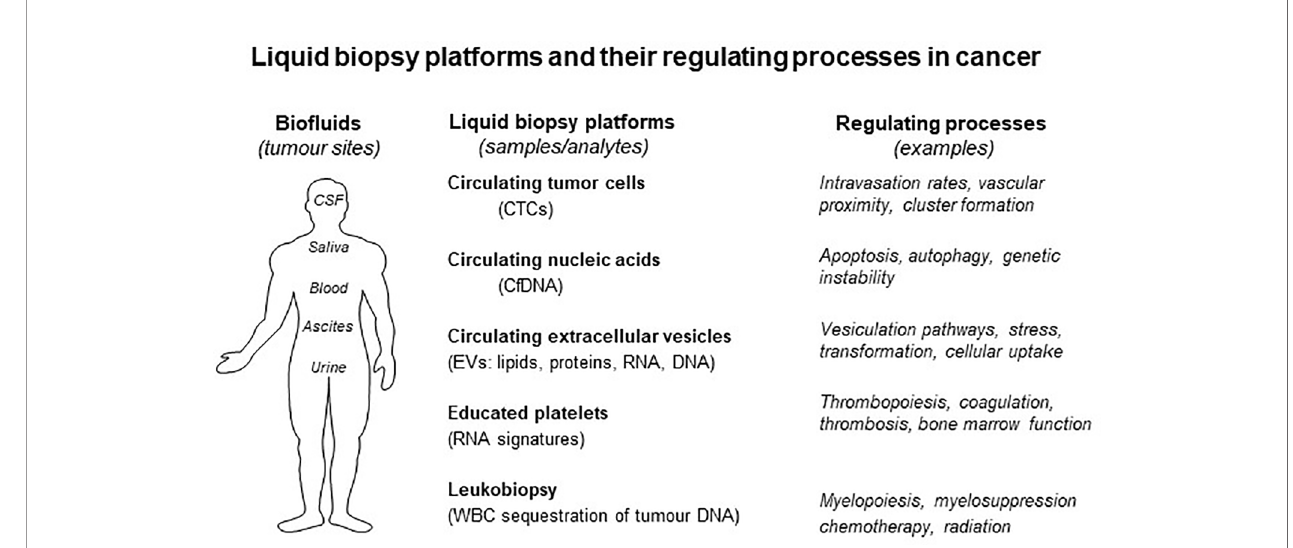
FIGURE 1 | Liquid biopsy platforms and processes that regulate them in cancer. Several processes affect the state of bio fl uids (right) and their content of liquid biopsy analytes. Each form of liquid biopsy (CTCs, cfDNA, EVs, platelets, and leukocytes) may be affected by unique regulatory in fl uences that may change the content of biological information (see text for